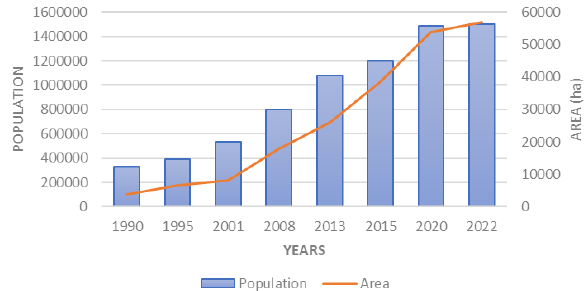
Figure 6: The relationship between population growth and urban sprawl in Abu Dhabi from 1990 to 2022